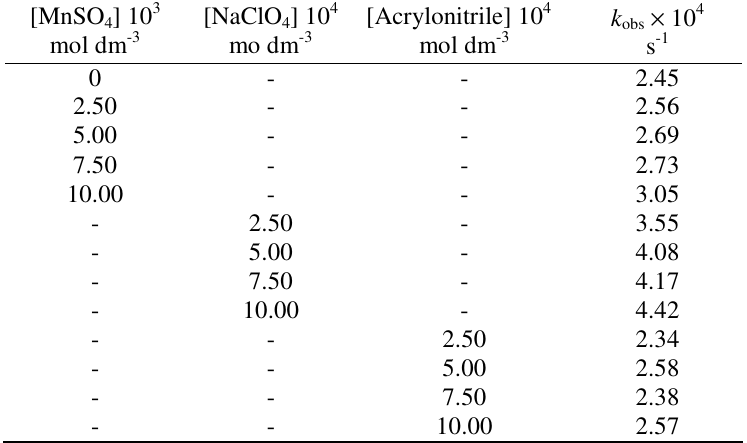
], [NaClO ] and [acrylonitrile] on reaction rates 4 4